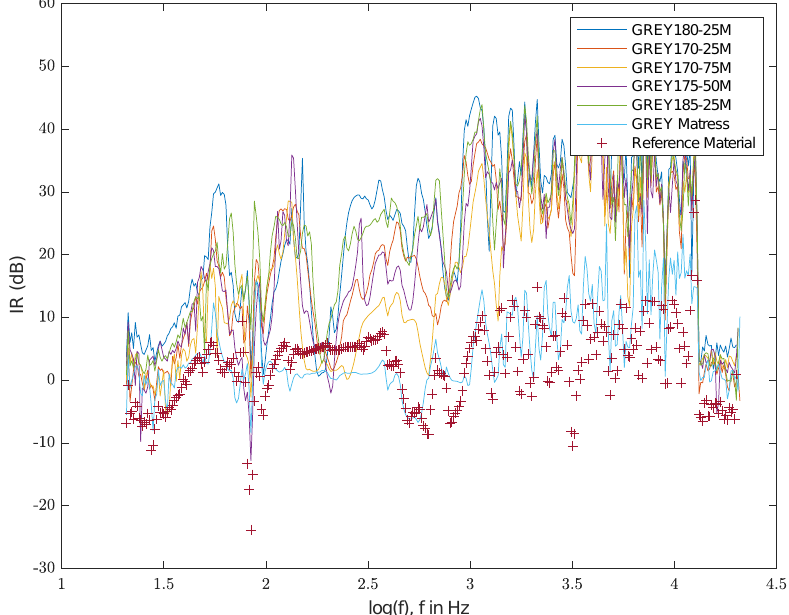
Figure 11. Reduction index of grey briquettes (lines) compared to the reference material (crosses). Volume 6.